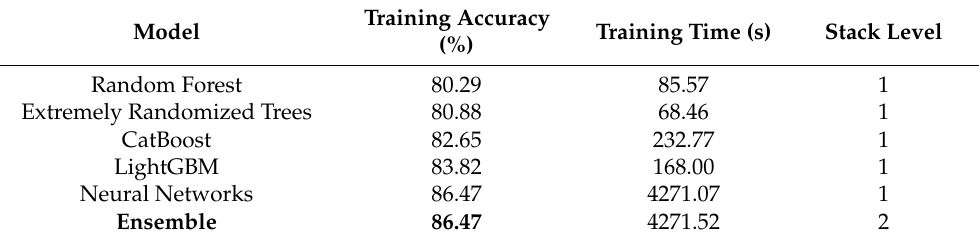
Table 4. Level I accuracy comparison of different models of EULUC-seg in terms of training accuracy, training time, and stack level. Note the training accuracy is the average overall accuracy of the 5-fold cross-validation during training.